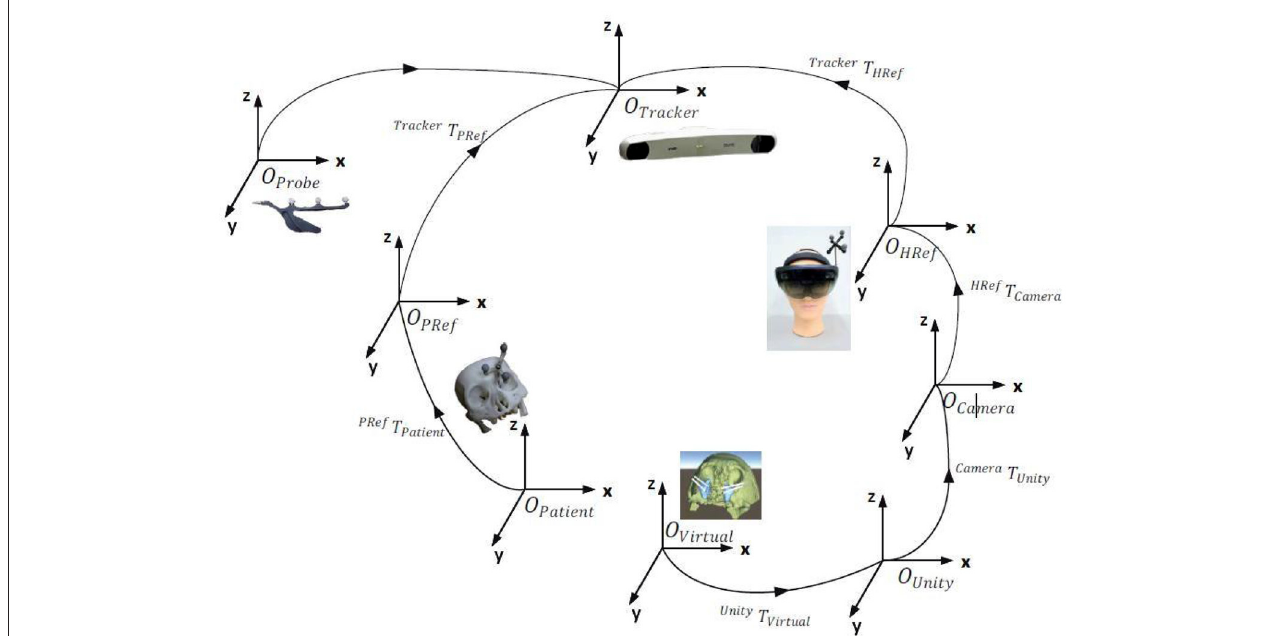
FIGURE 1 | Tracking calibration of MR display equipment, navigation system, and actual patients.